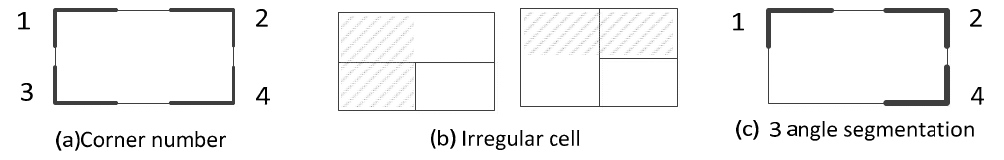
Figure 6. Schematic diagram of cell division by the combination of three corners.